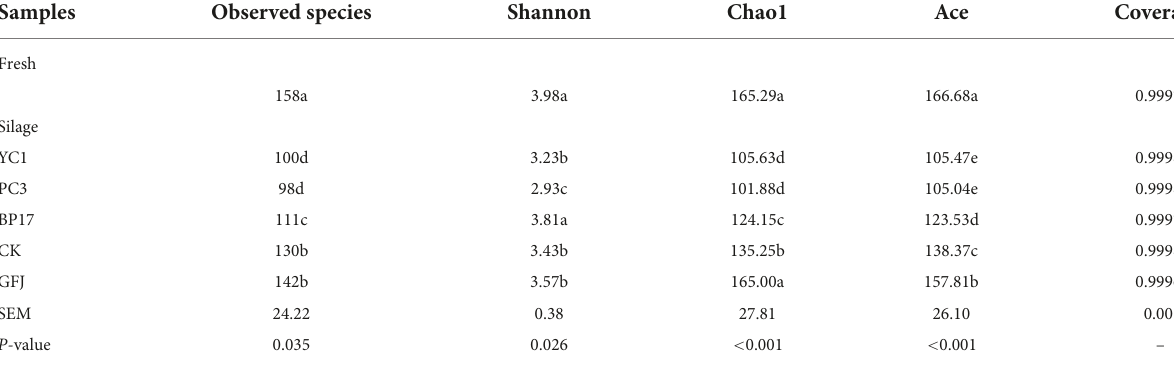
TABLE 5 The alpha-diversity of bacterial community of fresh and ensiled paper mulberry. Samples